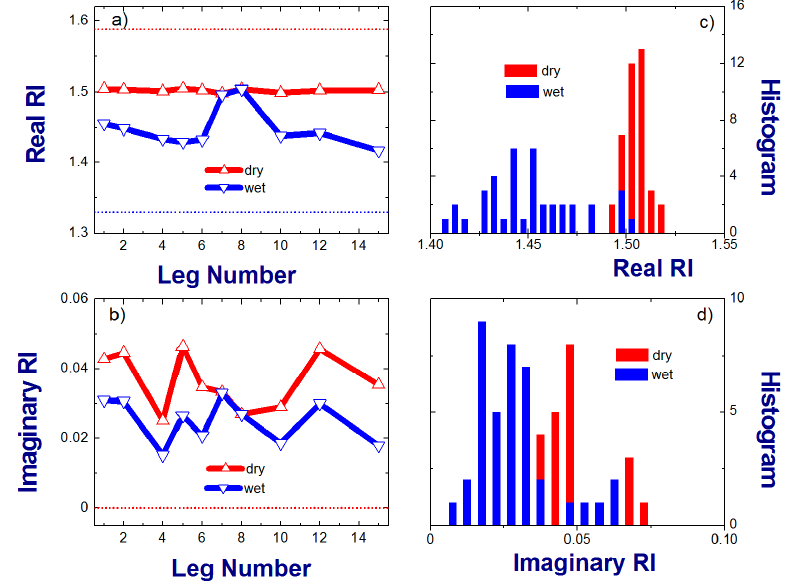
Figure 6. Example of RH-dependent dry and ambient values of the real and imaginary parts of the complex RI calculated for each FL on 25 February 2013 ( a , b ); the corresponding histograms obtained for all winter TCAP FLs ( c , d ). The real (n OPC = 1.588) and imaginary (k OPC = 0) parts of the complex RI set for OPC calibration are shown in ( a ) (magenta) and ( b ) (magenta), respectively. The real RI of water (n water = 1.33) is also shown (a, cyan). The imaginary RI of water (k water = 0) is equal to the imaginary RI used for OPC calibration (k OPC = 0).